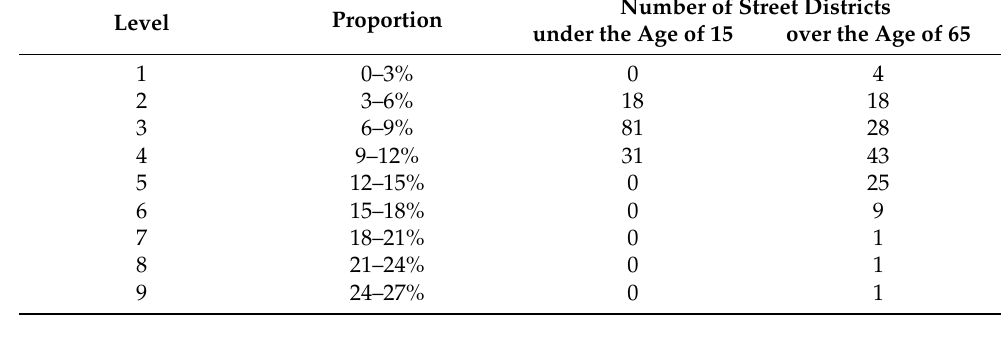
Table 2. Statistics of the young and old population proportion levels.